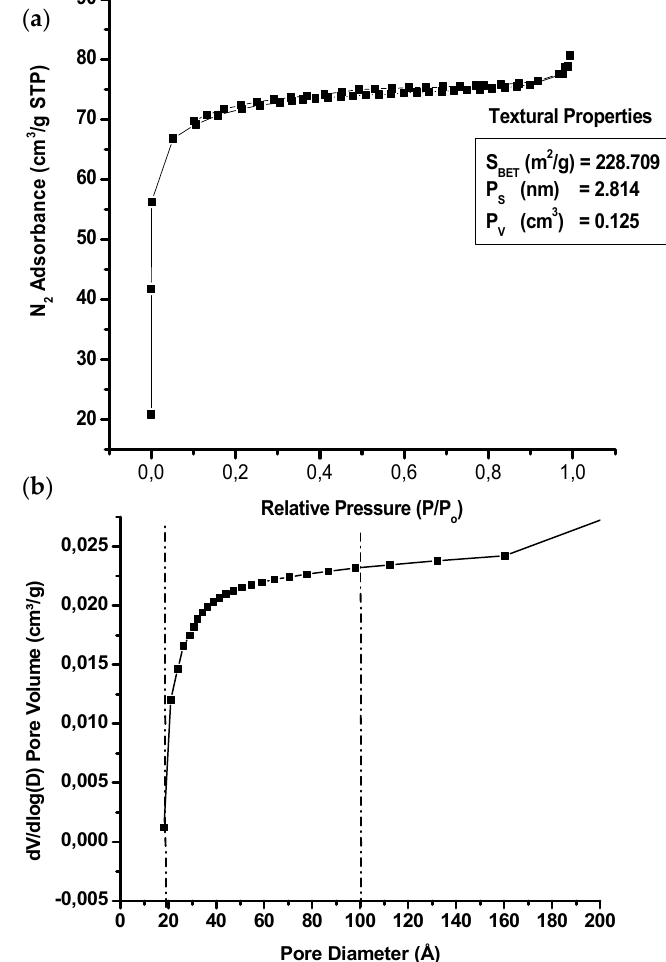
Figure 2. BET Isotherms ( a ) N 2 adsorption–desorption uptake and ( b ) calculated BJH pore distributions of a hydrothermally synthesised ZSM‐22 material.